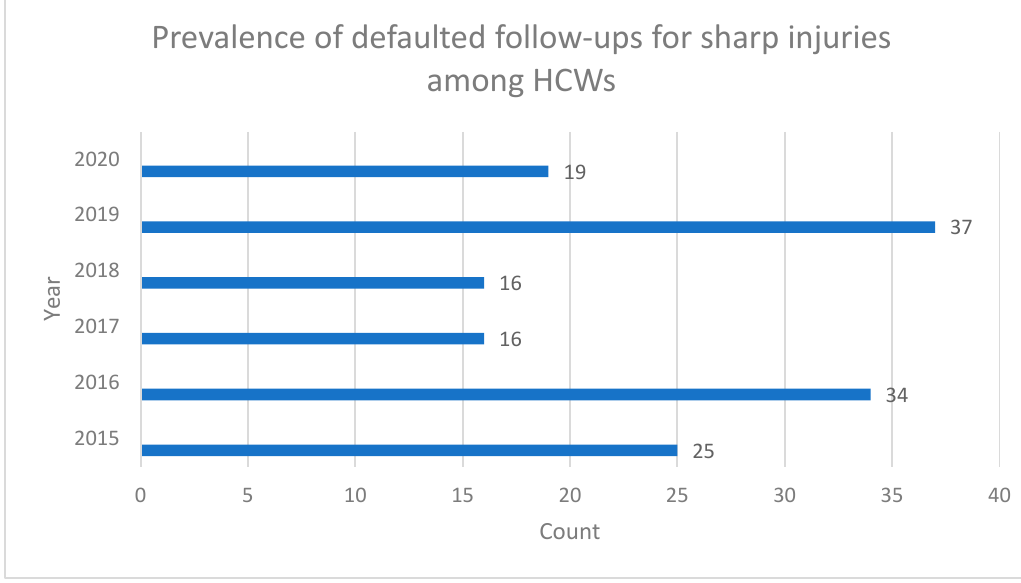
Figure 1. Prevalence of defaulted follow ups for sharp injuries among HCWs by year (n = 147).